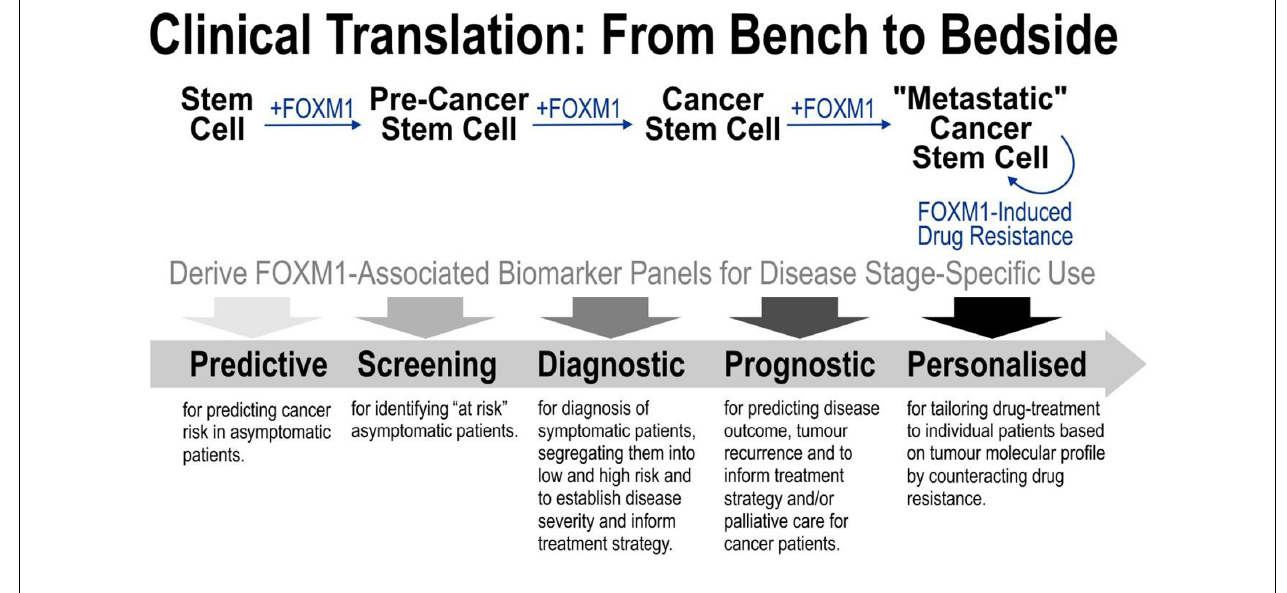
FIGURE 2 | Strategy for translating basic FOXM1 research into clinical benefits. FOXM1 has been implicated in all stages from cancer initiation, progression, metastasis to drug resistance. Understanding the detail molecular mechanisms specific to each disease stages would be important